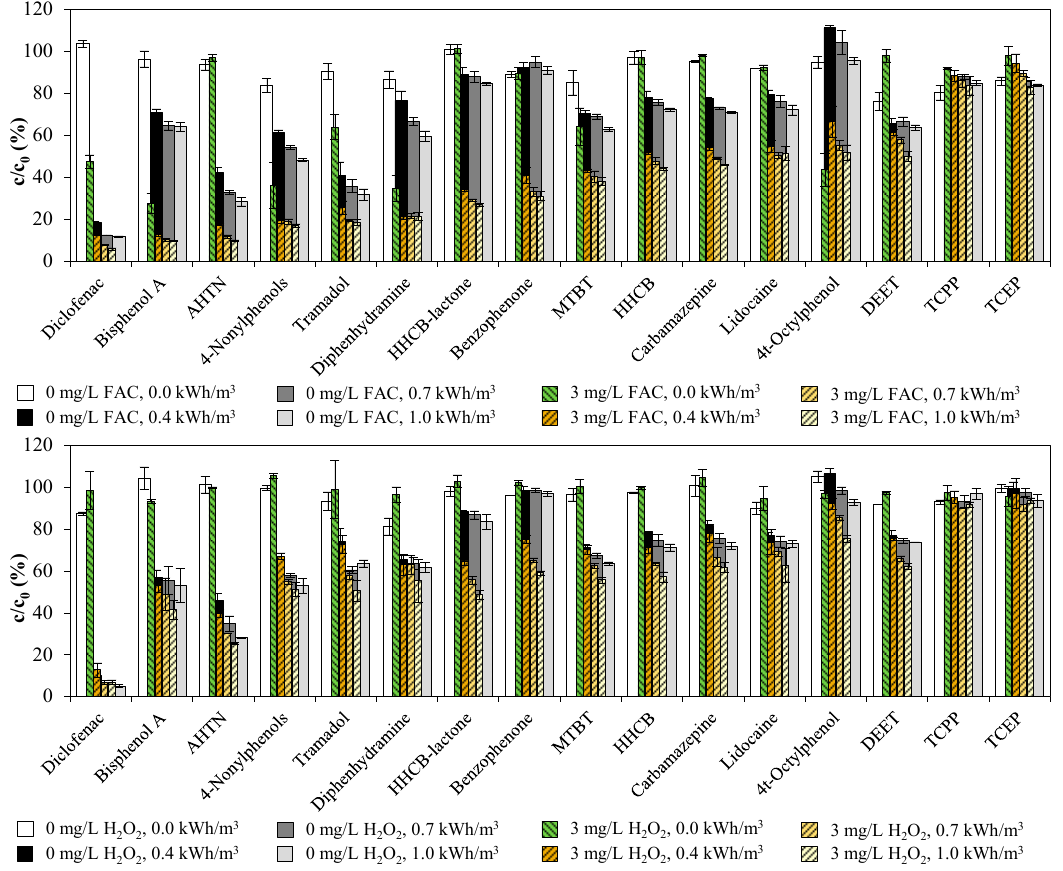
Figure 5. Removal of ECs found in WWTE by means of: UV/chlorine AOP ( top ); and UV/H 2 O 2 AOP ( bottom ), at 0 and 3 mg/L oxidant concentrations depending on UV energy consumption at 1 m 3 /h (Experiment 1).